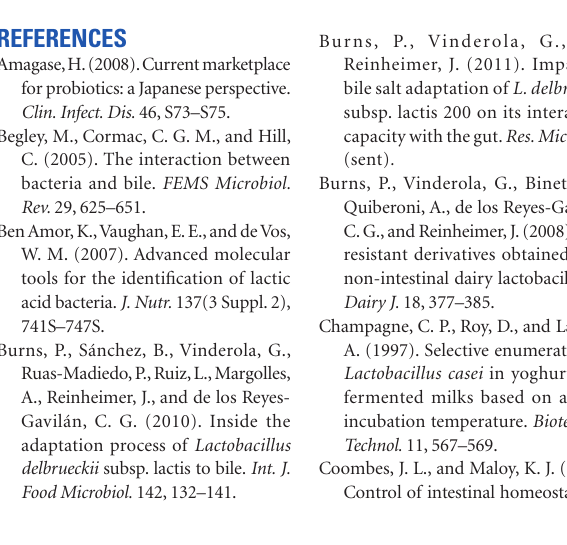
Figure 1 | FiTC-labeled (fluorescent) L. delbrueckii subsp. lactis 200 (above) and its non-autoaggregative bile-resistant derivative L. delbrueckii subsp. lactis 200 + (below) in the small intestine lamina propria after 30 min of their oral administration to mice. Magnification: 40 × . Arrows indicate